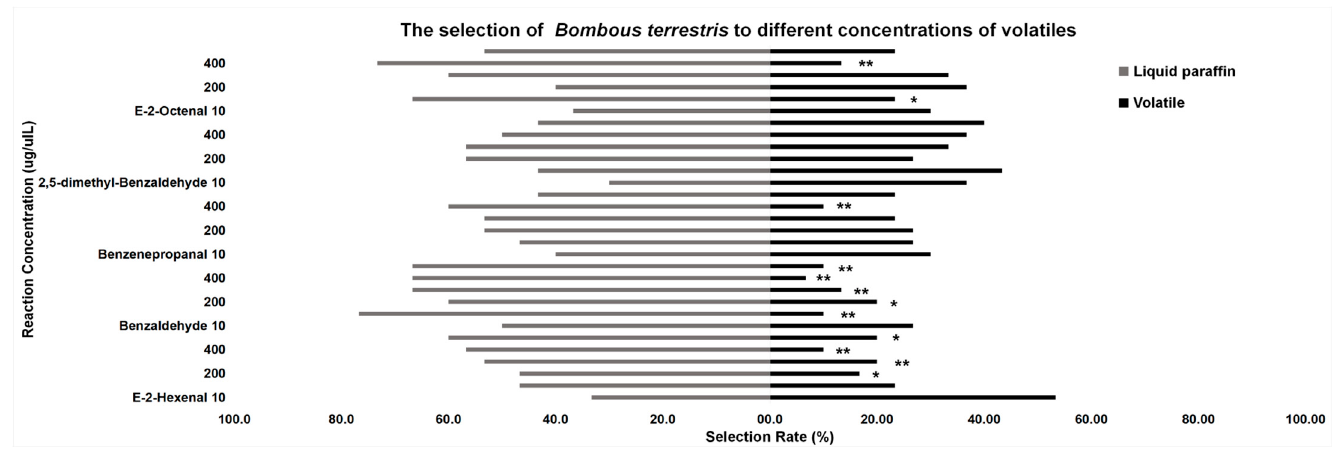
Figure 5. Behavior tests of A. mellifera. “*”means significant difference ( p < 0.05), “**” means ex- tremely significant difference ( p < 0.01). extremely significant difference ( p < 0.01).